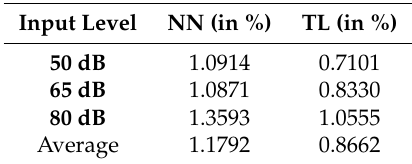
Table 1. MSE Comparison for NN and